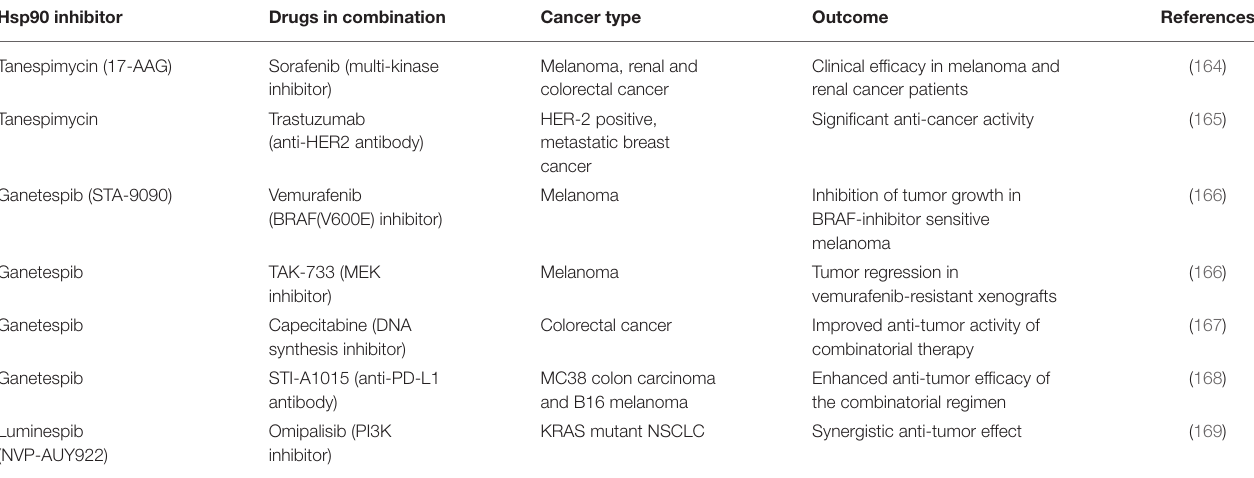
TABLE 5 | Preclinical and clinical studies where HSP90 inhibitors were combined with other anti-cancer